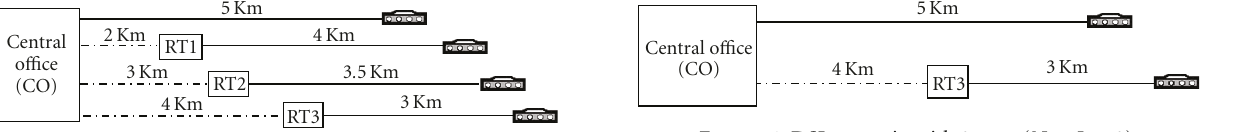
Figure 3: DSL “master” scenario for all simulations.